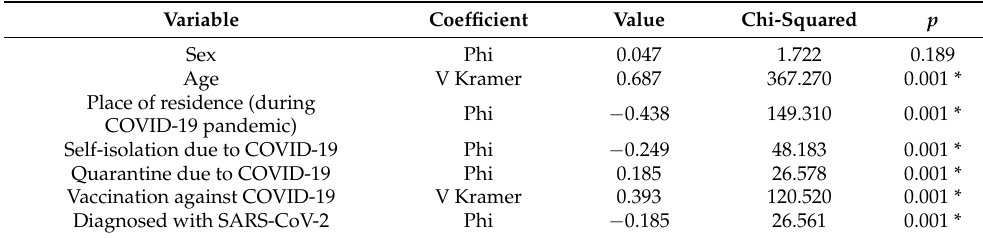
Table 2. Homogeneity of groups under